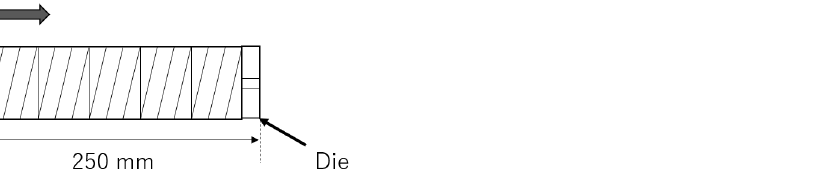
Figure 9. Screw configuration to investigate Nusselt number. The arrow indicates the direction of